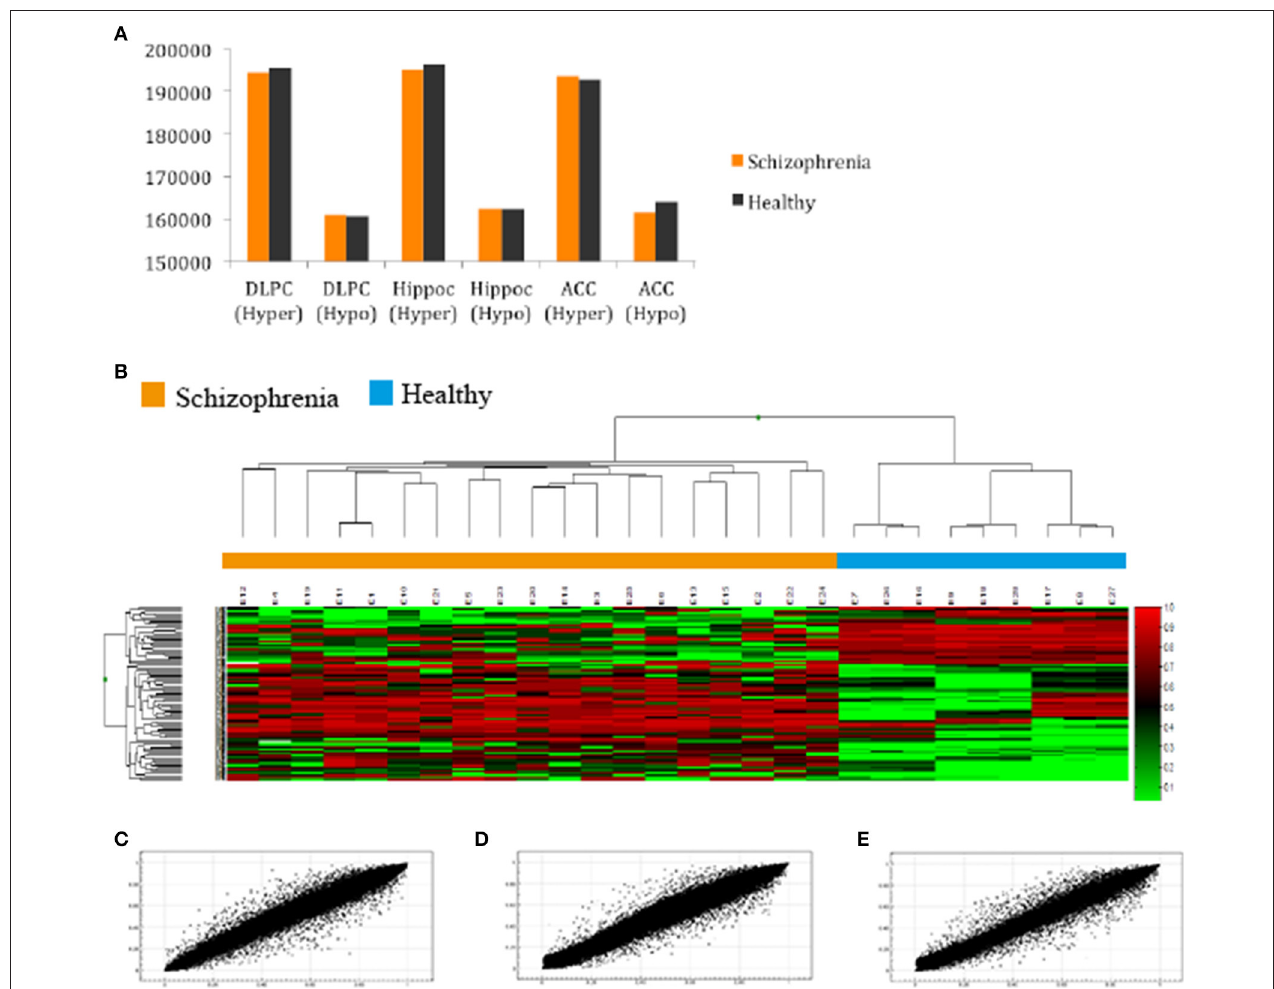
FIGURE 1 | (A) Total number of hyper and hypomethylated CpG sites both in schizophrenic and healthy samples; (B) Hierarchical cluster analysis of 301 probes in the total samples included in our study with a 0.20-fold change in β -values as the cut-off ( SD < 30%; Green, samples with lowest methylation level; Red, samples with highest methylation level). Cluster analysis discriminated between schizophrenic patients (orange box) and control samples (blue box); (C,D,E) Representative example of the scatter plot for CpG methylation values (AVG β ) between healthy and schizophrenic samples in the (A) DLPC ( R 2 = 0.9945); (B) Hippocampus ( R 2 = 0.9949); and (C) ACC ( R 2 = 0.9931).